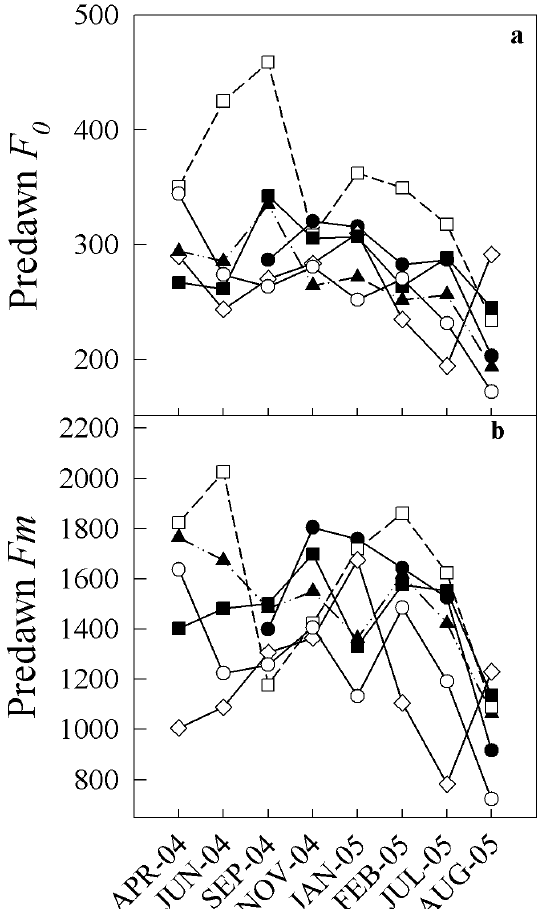
Figure 3 - Seasonal variation in predawn basal ( a ) and maximum fl uorescence yield ( b ) ( F and F respectively). 0 pd m pd Species symbols as for Figure Multiple linear regressions indicated that only NRD showed a negative relationship with Ψ and pd F /F in Clusia , Erythroxylum and Eugenia . Both v m pd parameters were affected in Erythroxylum , while only to Ψ or F /F responded to NRD in Clusia pd v m pd and Eugenia , respectively (Table IV). For midday measurements, only Ocotea showed a signi fi cant negative relationship between F /F and VPD v m md (Table V). The first two axes of the PCA explained 41.89% and 26.90% of the variation observed in the six traits, respectively (Table VI). The fi rst axis was most strongly associated with F /F , F and F . v m pd m pd 0 pd The second axis was most strongly associated with